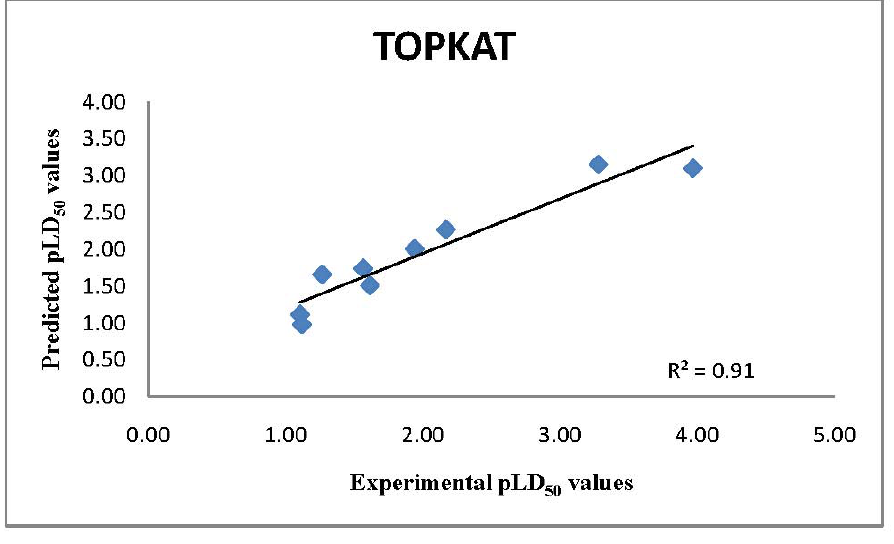
model predictions. 50